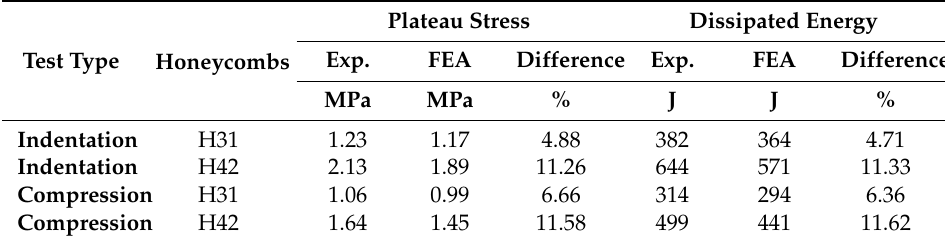
Table 4. Comparison between FEA and experimental results at 5 ms ´ 1 .